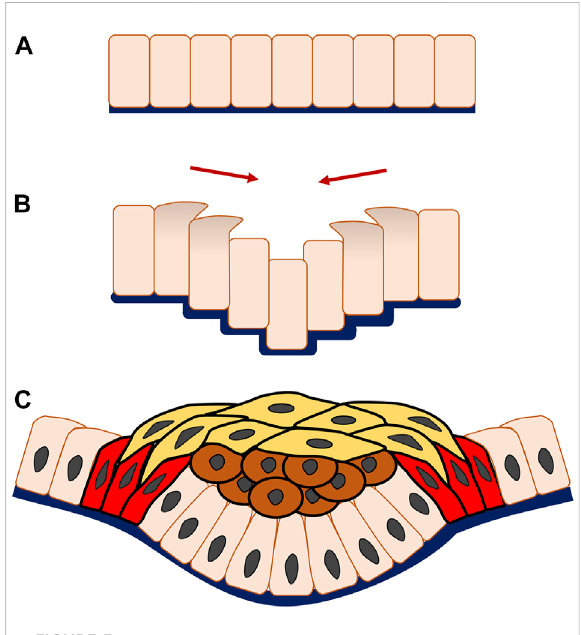
FIGURE 3 Multicellular system of epithelial invagination in early tooth development. As the invagination begins, cells at the edge of the monolayer (A) migrate vertically with apical and centripetal protrusion (B) , making the central adjacent cells telescope downwards, thereafter known as vertical telescoping movement. Interestingly, this occurs without cell shape change and triggers the epithelial layer to bend inwards and form an invagination. Subsequently, the multicellular invagination is formed by strati fi cation of the central suprabasal cells (brown cells), horizontal shrinking driven by cell intercalation of the super fi cial suprabasal cells (yellow cells) and canopy contraction of the basal epithelial cells (red cells) (C)